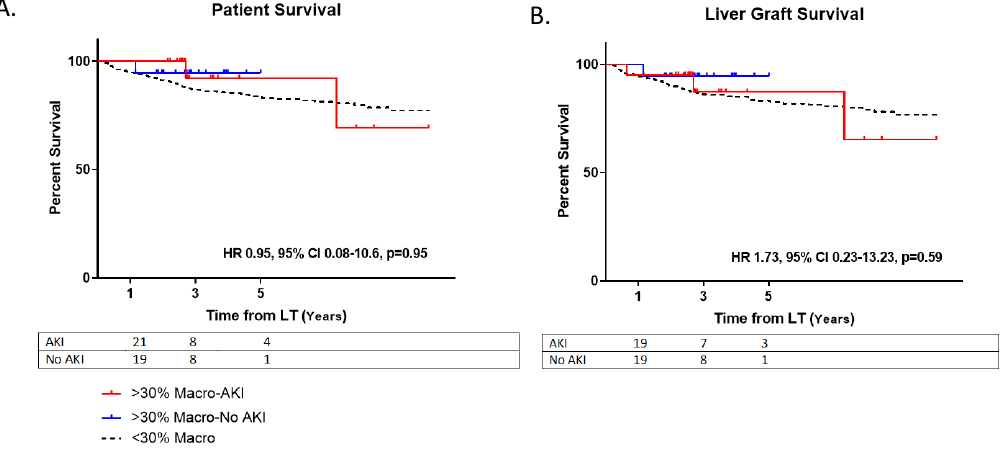
Figure 3. Survival. ( A ) Patient survival post-LT. Hazard ratio (HR); Confidence Interval (CI). ( B ) Liver allograft survival post-transplant. Moderately steatotic grafts with AKI ( > 30% Macro-AKI); Moderately steatotic grafts without AKI ( > 30% Macro-No AKI); Non-steatotic grafts ( < 30% Macro).